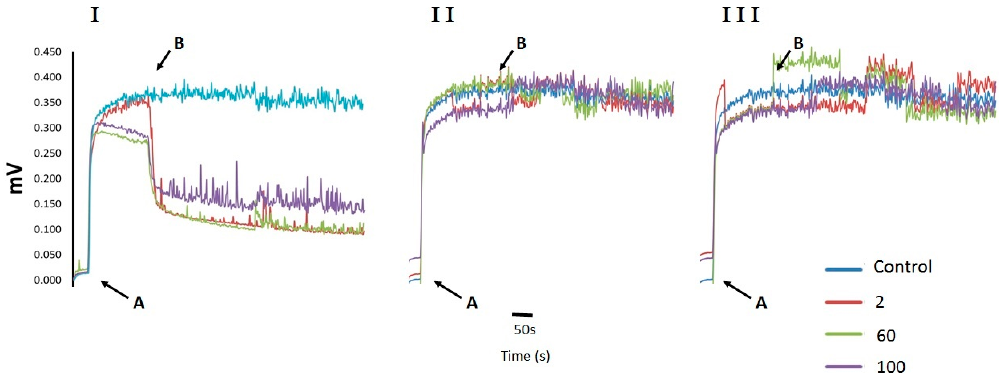
Figure 2. Changes in Δψ in response to different concentrations of CH, OCH or CGH. All concentrations are expressed in µg · mL − 1 . The numbers correspond to each antifungal tested, ( I ) CH; ( II ) OCH; ( III ) GCH. Additions were: A = cells; B = Antifungal. U. maydis , 25 mg wet weight.